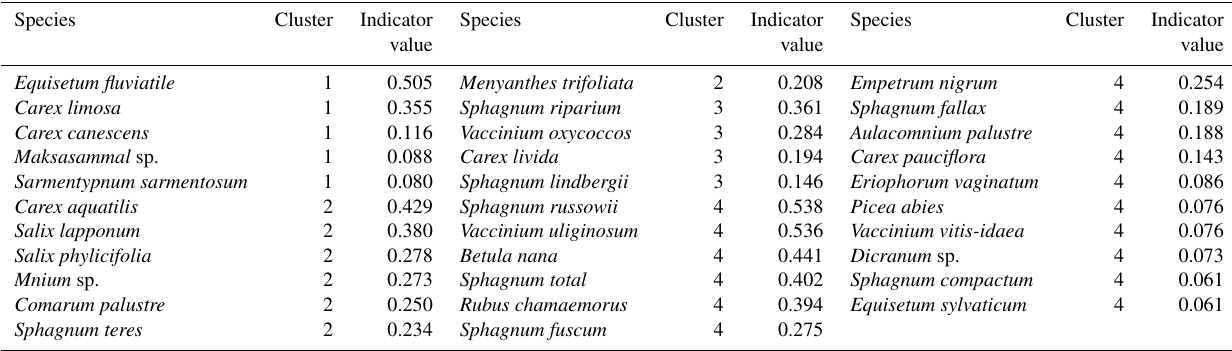
Table A2. Indicator plant species of plant community clusters of the methane (CH 4 ) flux sample plots derived from non-metric multidimen- sional scaling (NMDS)